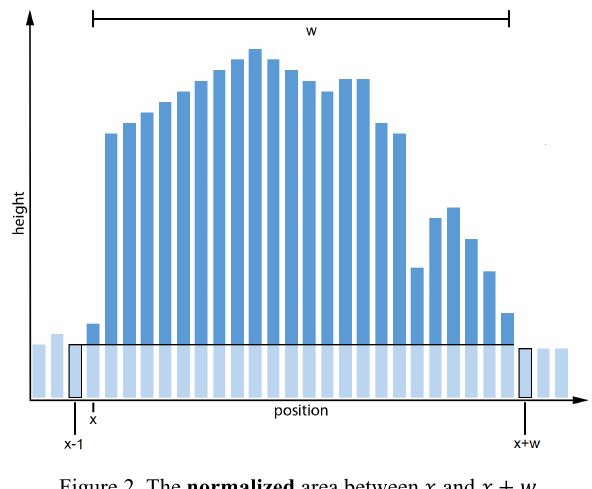
Figure 2. The normalized area between 6 and 6 + 2